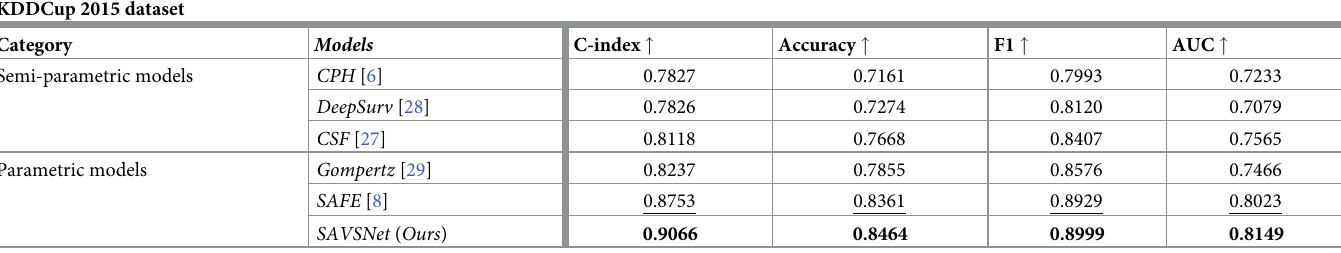
Table 2. The results on KDDCup 2015